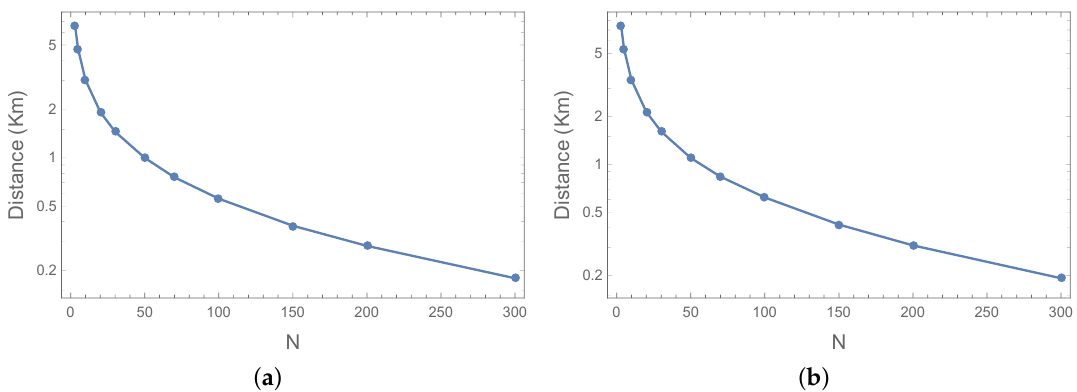
Figure 3. The maximum distance from the source to a user with conferencing key rate K → 0, in terms of different number N of network users. The thermal noise is set to ¯ n = 0.05 in ( a ) and ¯ n = 0 in ( b ), respectively.